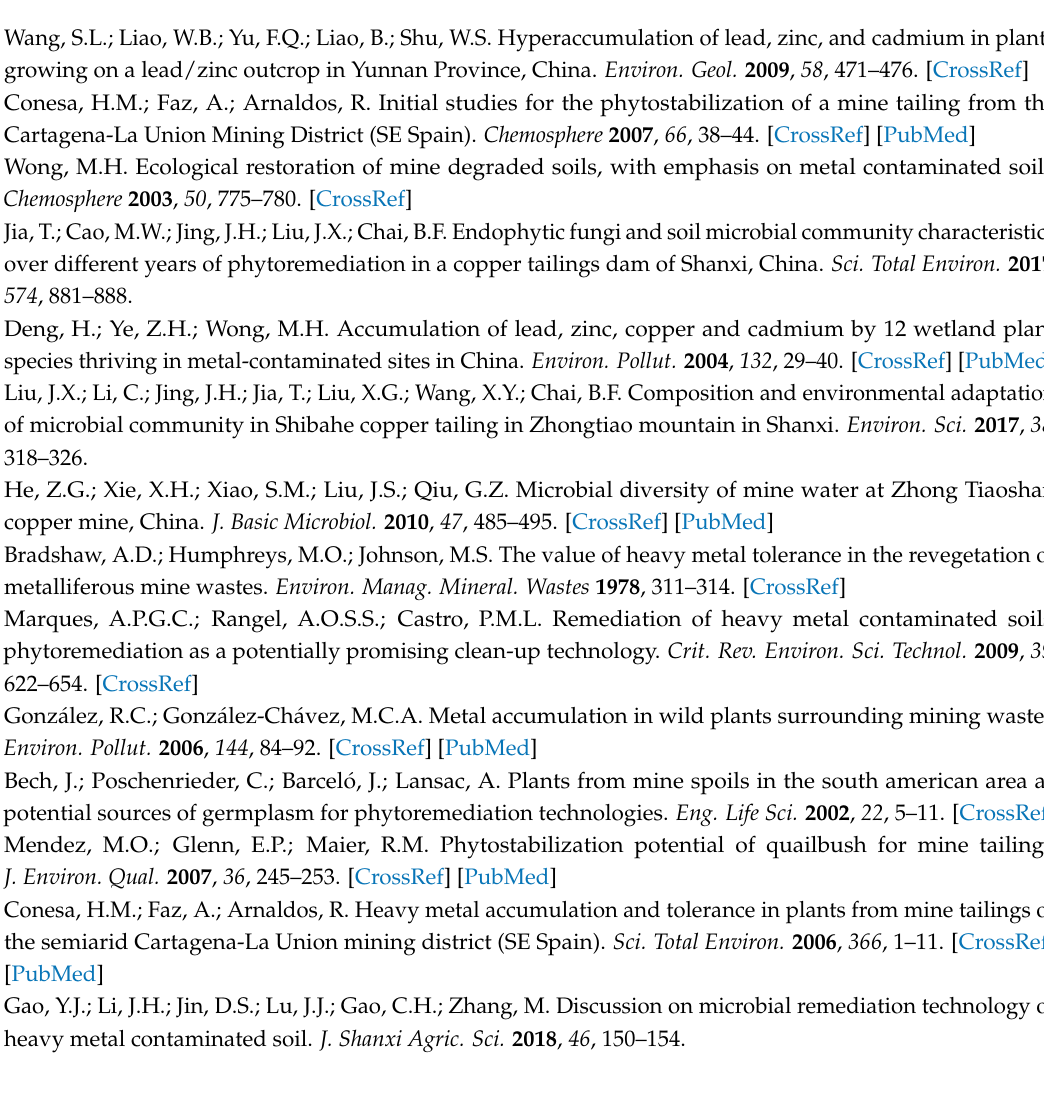
Table S1: The Pearson correlations among root chemical properties, heavy metals and diversity indices of rhizophere soil microbial community, Table S2: The Pearson correlations among soil physicochemical properties, heavy metals and diversity indices of non-rhizophere soil microbial community, Table S3: The Pearson correlations among transfer factors of different heavy metals and diversity indices of soil microbial